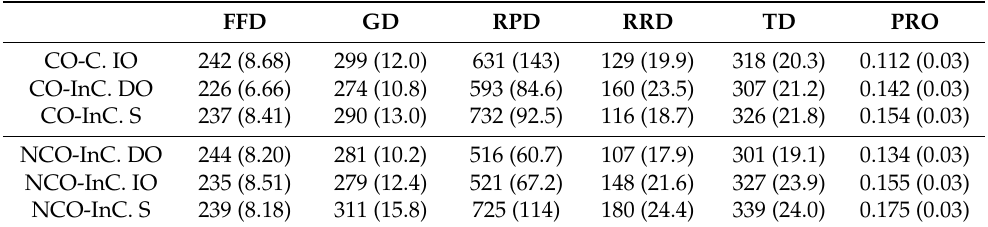
Table 5. Mean Values for the Six Conditions (in msec. for durations), with Standard Errors in Parentheses, for the Six Eye-tracking Measures for the spillover-2